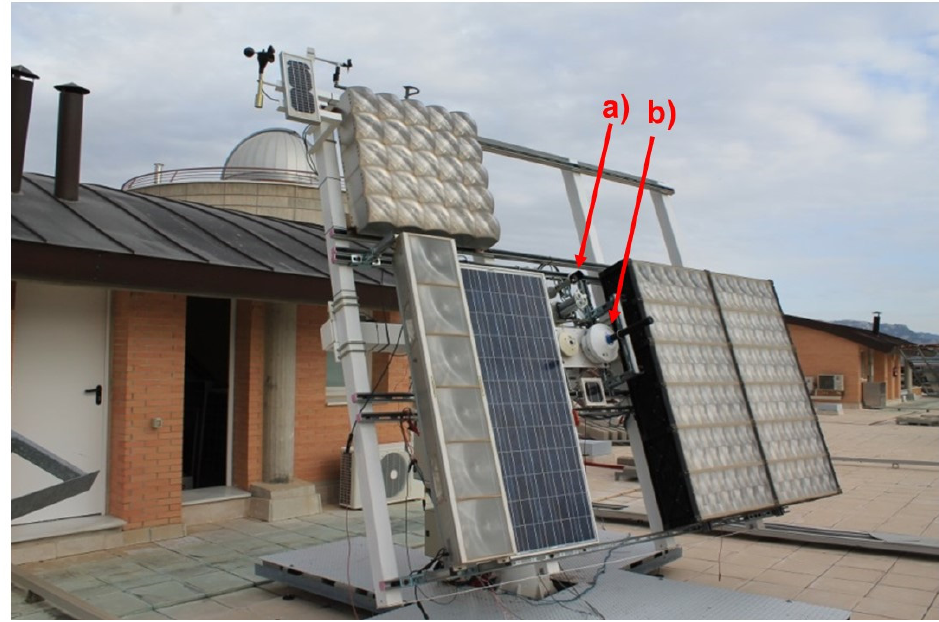
Figure 1. Pyrheliometer ( a ) and spectroradiometer with collimator tube ( b ) used in this work.